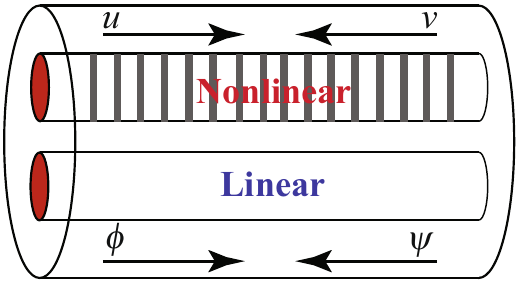
Figure 1. Schematic diagram of a semilinear dual-core system where a nonlinear core with a Bragg grating is coupled with a linear